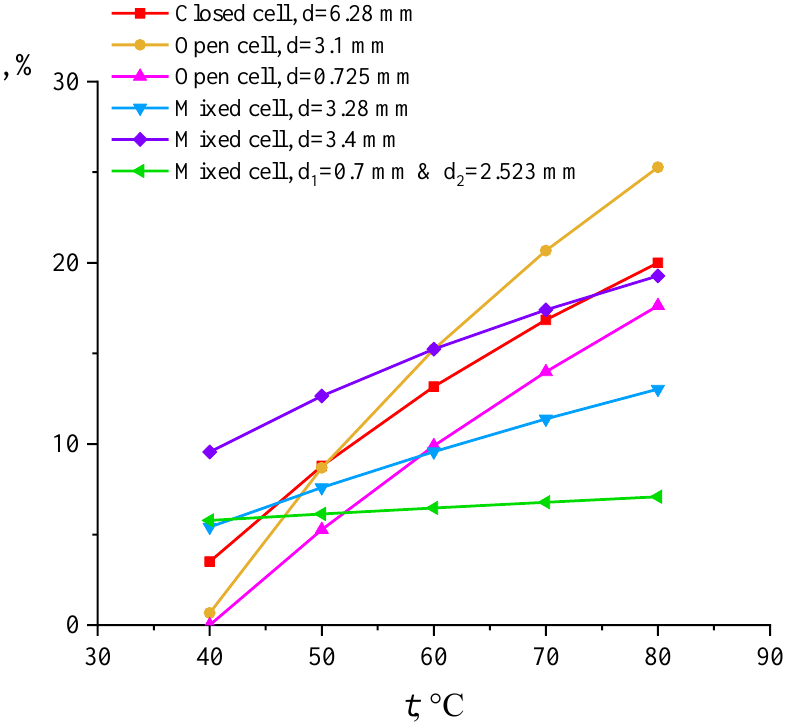
Figure 6. The contribution of the convective component in percent (%) relative to the value of effective thermal conductivity.